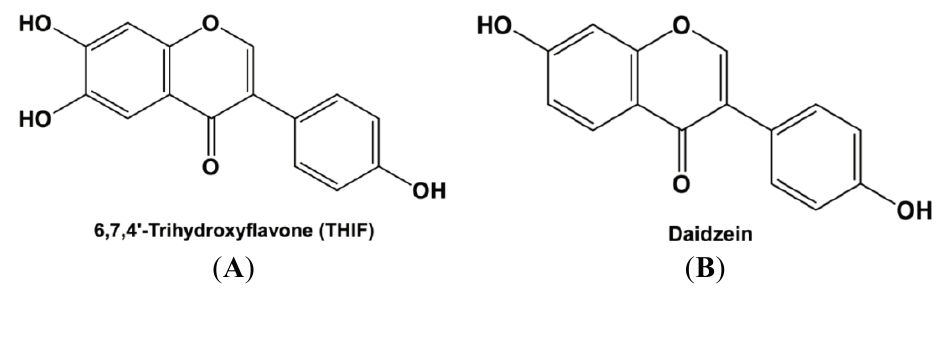
Figure 1. Molecular structure of 6,7,4'-trihydroxyisoflavone (6,7,4'-THIF) ( A ) and daidzein ( B